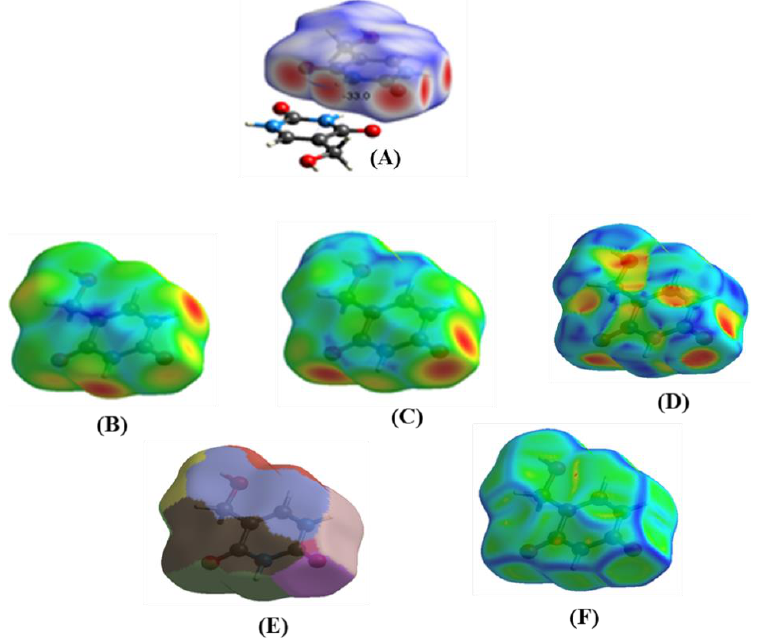
Figure 4. Hirshfeld surface for 5-HMU: mapped with d norm ( A ), d i ( B ), d e ( C ), shape index ( D ) curvedness ( E ), Fragment patch (F ).